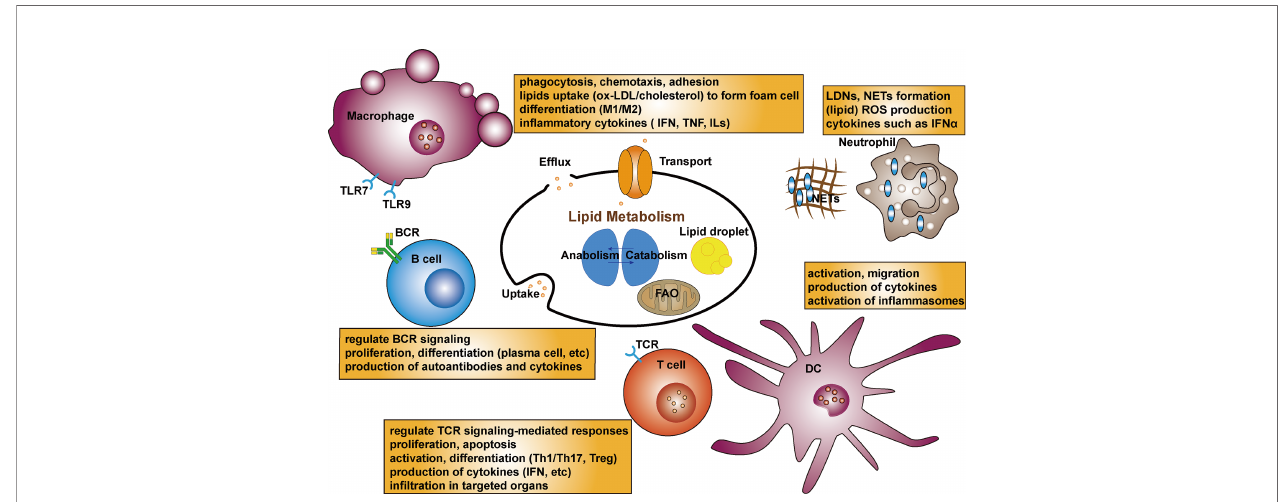
FIGURE 2 | Schematic diagram of the lipid metabolism in immunocytes in SLE. Lipid rafts can regulate TCR signaling-mediated responses. Lipid metabolism as an important facilitator of T cell differentiation, can activate CD4+T cells then differentiate into Th or Treg cells. Lipid biosynthesis including cholesterol and fatty acid is critical for proliferation, apoptosis and production of cytokines in T cells. Dyslipidemia can promote the autoantibodies in B cells. Lipid rafts also regulate BCR signaling. Lipids composition could affect B cell proliferation, differentiation and production of autoantibodies as well as interleukins. Fatty acids can modulate the process of macrophage differentiation as well as adhesion on endothelial cells and their chemotaxis. The uptake of ox-LDL by macrophages uptake by the macrophage is the initial step to foam cell formation. Targeting receptors associated lipid metabolism can affect differentiation of monocytes and production of proin fl ammatory cytokines, which are related to TLR7 and TLR9 expression. Lipid pro fi les promote activation and migration of DCs. LDLs promote the production of IL-6 in DCs. Besides, cholesterol-enriched DCs show augmented cytokine secretion and activation of in fl ammasome. A subset of lupus proin fl ammatory neutrophils (LDGs) increase and promote risk of atherosclerosis. Oxidation of cholesterol and phospholipids can lead to lipid peroxidation, and higher level of ROS production with enhanced catalase activity of neutrophils are seen in SLE. NETs stimulate production of IFNs and proin fl ammatory cytokines. NETs possess active oxidant- generating enzymes, and modify